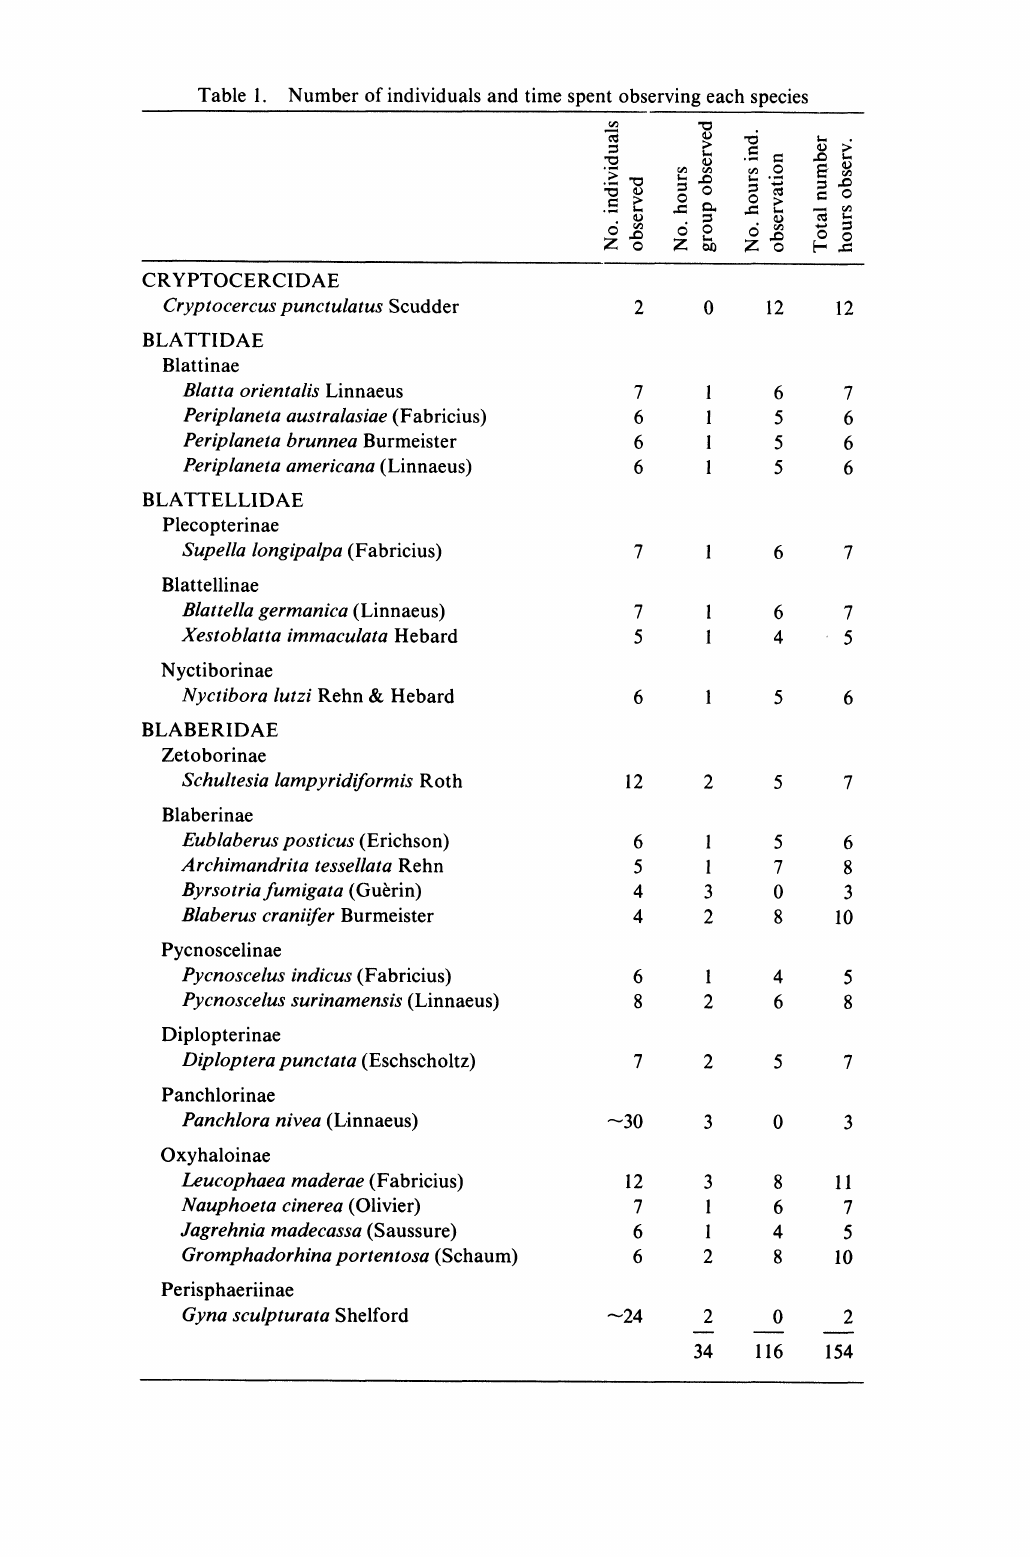
CRYPTOCERCIDAE Cryptocercus punctulatus Scudder BLATTIDAE Blattinae Blatta orientalis